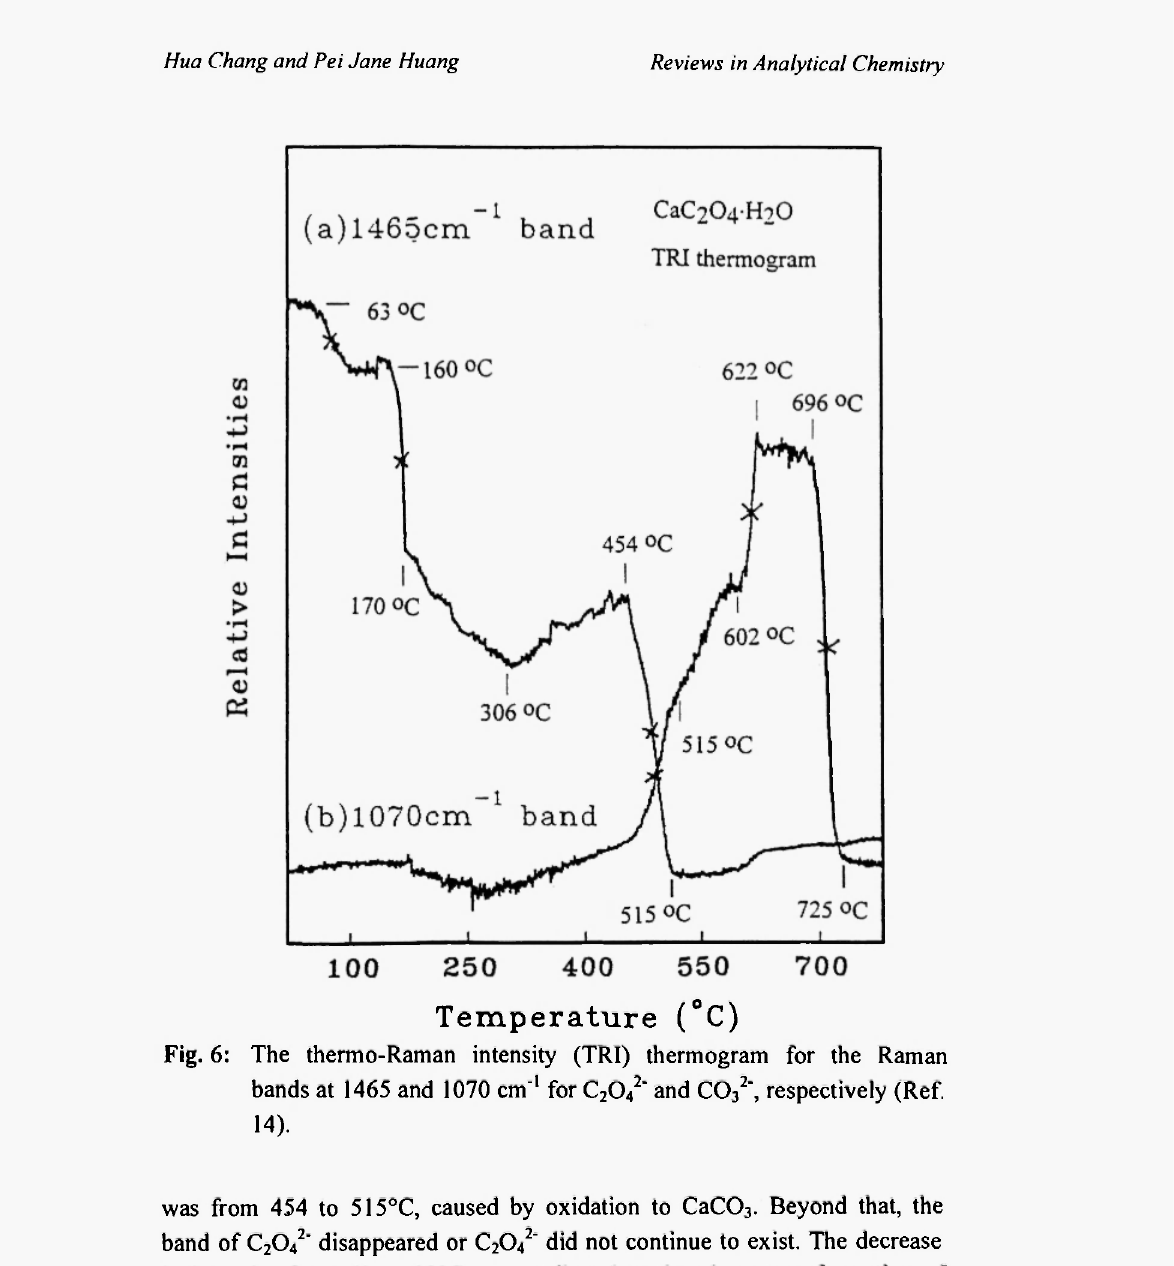
Fig. 6: The thermo-Raman intensity (TRI) thermogram for the Raman bands at 1465 and 1070 cm" 1 for C 2 0 42 " and C0 32 ", respectively (Ref.